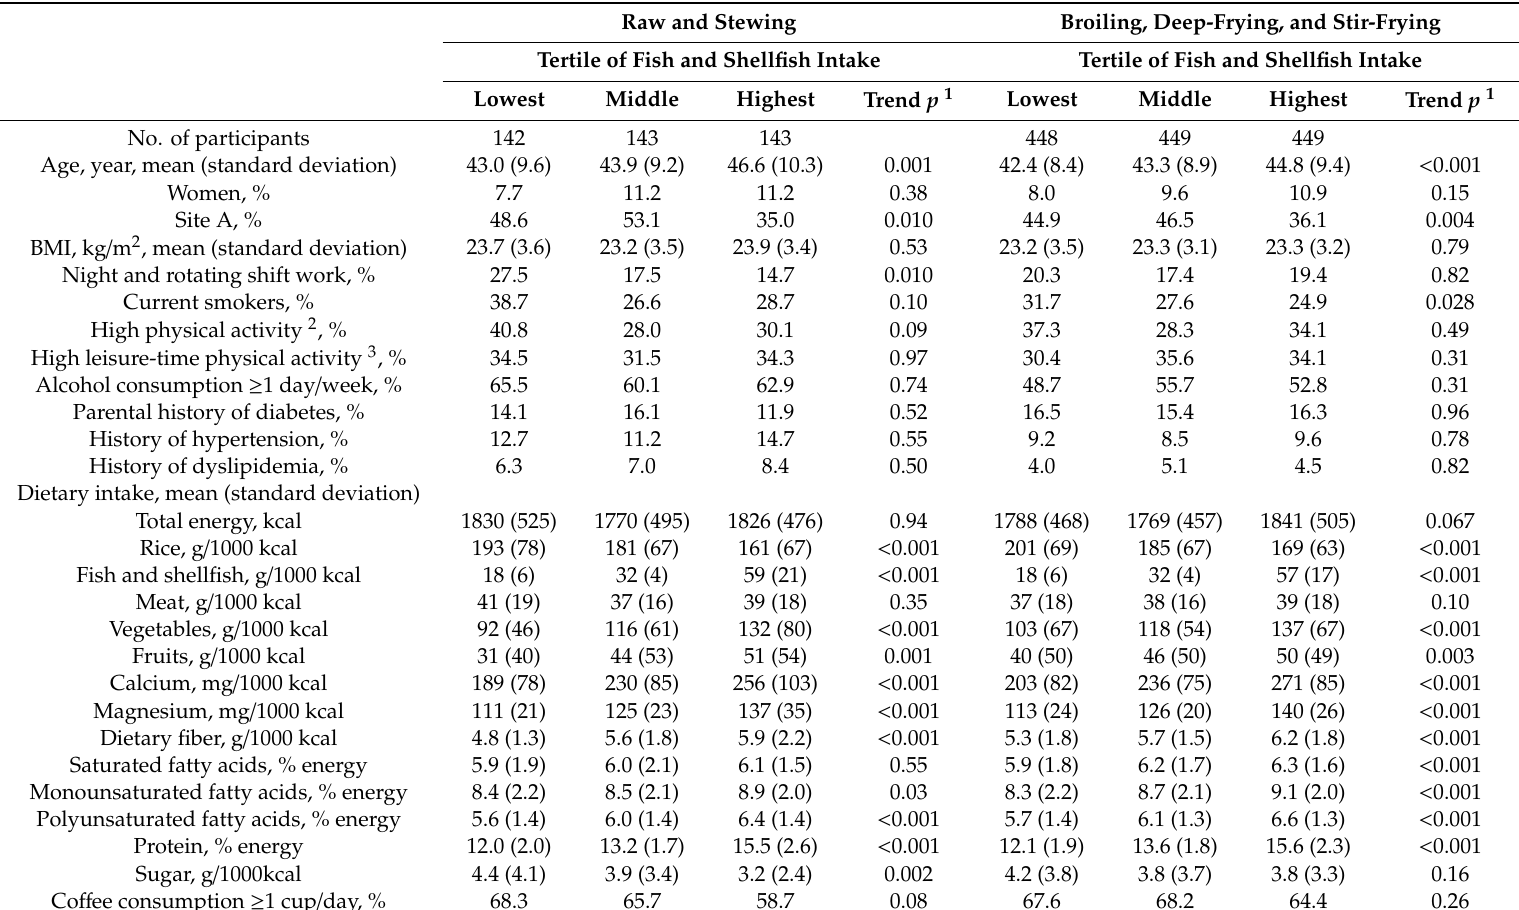
Table 1. Characteristics of participants according to tertiles of fish and shellfish intake by fish cooking methods. Raw and Stewing Broiling, Deep-Frying, and Stir-Frying Tertile of Fish and Shellfish